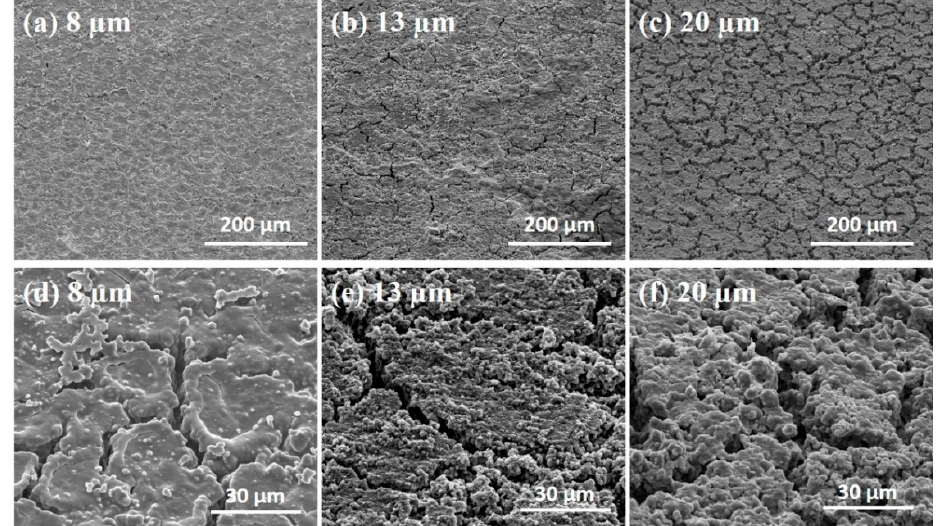
Figure 8. Morphologies of anode surfaces after 100 cycles. Si micropillars are produced by laser irradiation on slurry layers of different thicknesses: ( a , d ) 8, ( b , e ) 13, and ( c , f ) 20 µm. ( a – c ) are in low magnification. ( d – f ) are in high magnification.